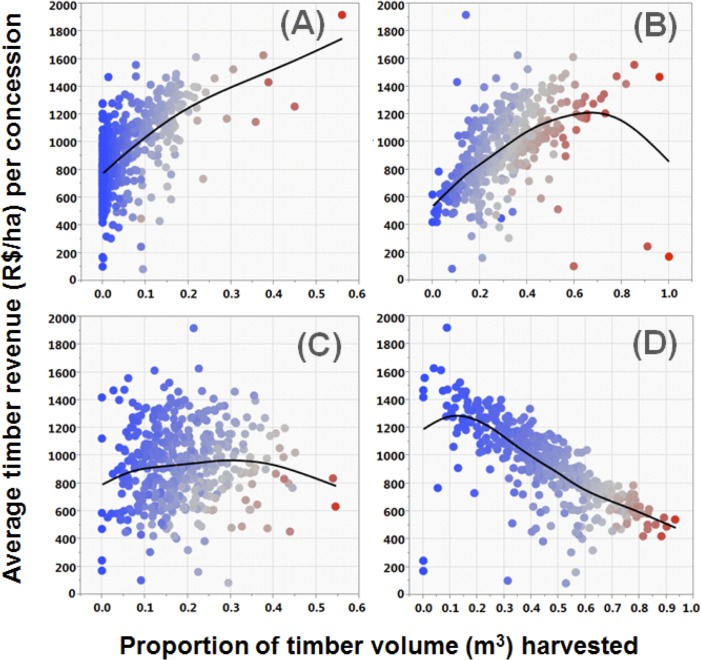
Relationship between volumetric proportions of timber species aggregated by price brackets (classes A, B, C, and D) and mean gross revenues per hectare expected from each authorized concession area. Timber value classes are ordered top to bottom from the highest (A) to the lowest (D). Symbols are colour-coded from low (blue) to high (red) values according to the respective proportion of each price class contributing to the overall timber revenue of each concession site. Solid lines represent a smoother (λ = 0.8) running through all data points.